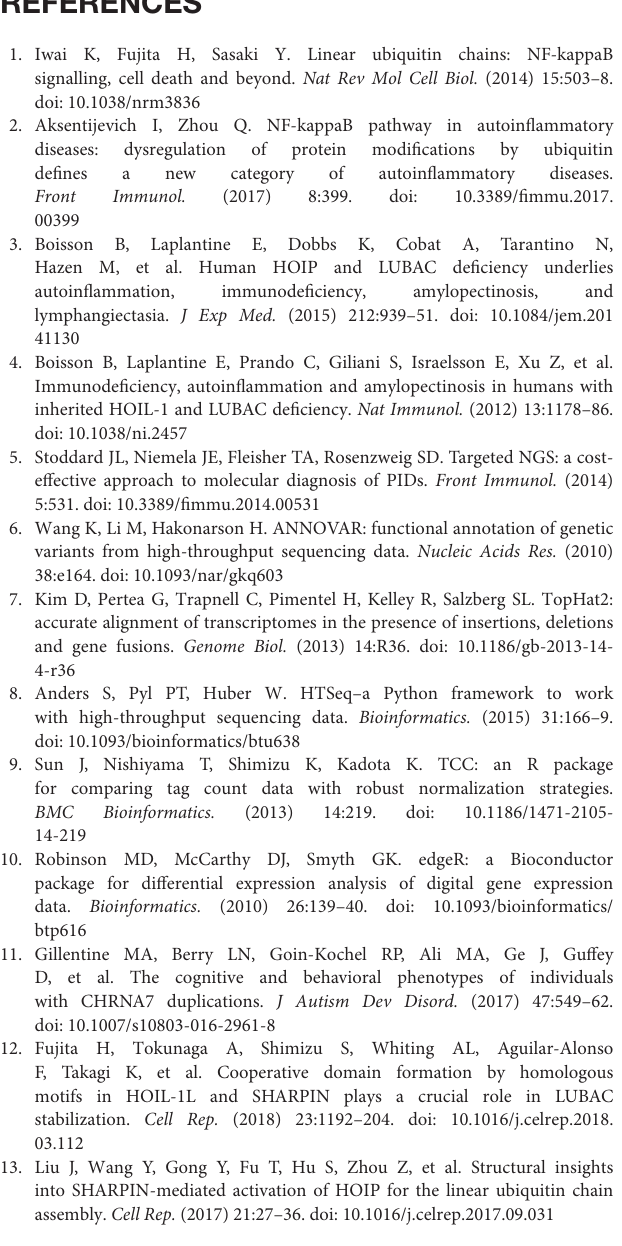
Figure S7 | Transcriptomic features of the HOIP deficient patient. (A) Hierarchical clustering of the RNAseq of whole blood and PBMCs of the HOIP deficient patient. (B) M-A plot analysis showing differentially expressed genes in whole blood RNAseq of the HOIP deficient patient and the healthy controls. Red dots indicate gene expression levels with statistical